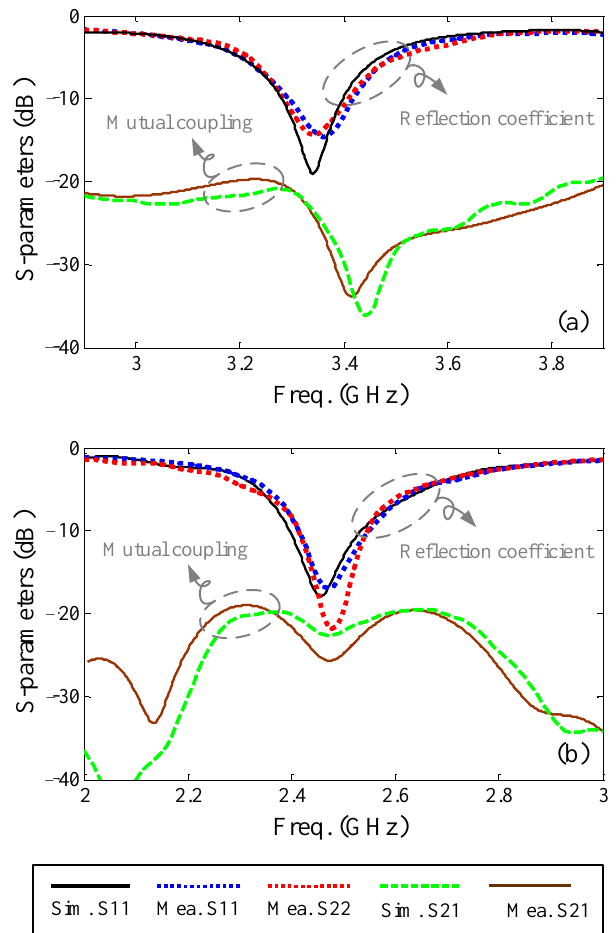
Figure 10. S-parameter performance of a field-domain SICS [58]. ( a ) State 1, ( b ) State 2. The dashed lines indicate the measurement results, the solid lines indicate the simulation results.